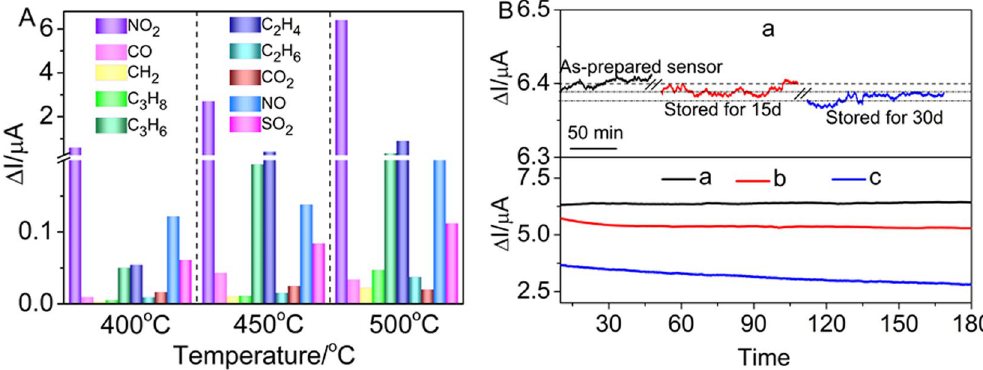
Figure 8. ( A ) Selectivity of the sensor based on Gd 1.95 Ca 0.05 Zr 2 O 7 + δ substrate in 500 ppm various gases at 400, 450 and 500 °C, respectively (applied potential − 300 mV, flow rate 200 cm 3 /min); ( B ) Stability test for the sensors at 500 °C in the presence of 500 ppm NO 2 (applied potential − 300 mV, flow rate 200 cm 3 /min): (a) Gd 1.95 Ca 0.05 Zr 2 O 7 + δ ; (b) Gd 1.95 Sr 0.05 Zr 2 O 7 + δ ; Gd 1.95 Ba 0.05 Zr 2 O 7 + δ